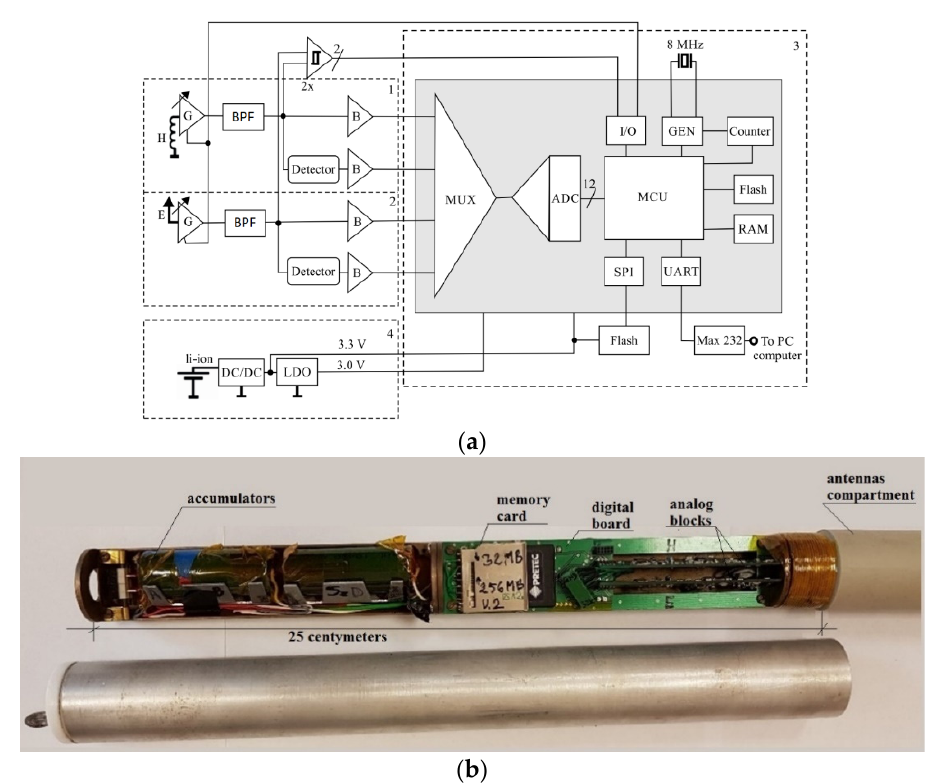
Figure 4. Autonomous EM field receiver. ( a ) block diagram of an integrated EM receiver, ( b ) inside the receiver unit.